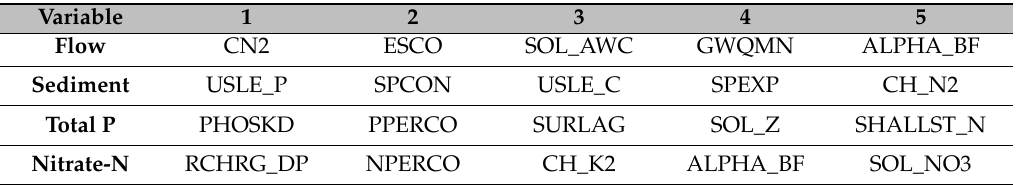
Table 6. Top five parameters identified as sensitive for flow, sediment, total P, and